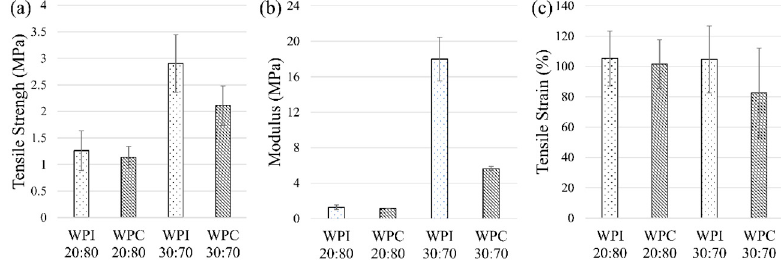
Figure 5. 20:80 vs. 30:70: Average ( a ) tensile strength ( b ) modulus and ( c ) tensile strain, all with error bars at 95% confidence level.